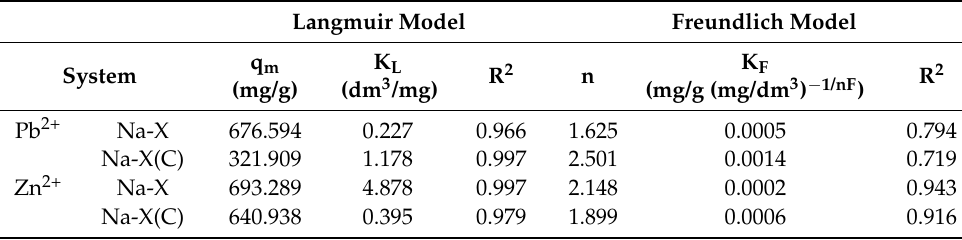
Table 4. Isotherm parameters of Pb 2+ and Zn 2+ adsorption on the Na-X and Na-X(C) surfaces at pH